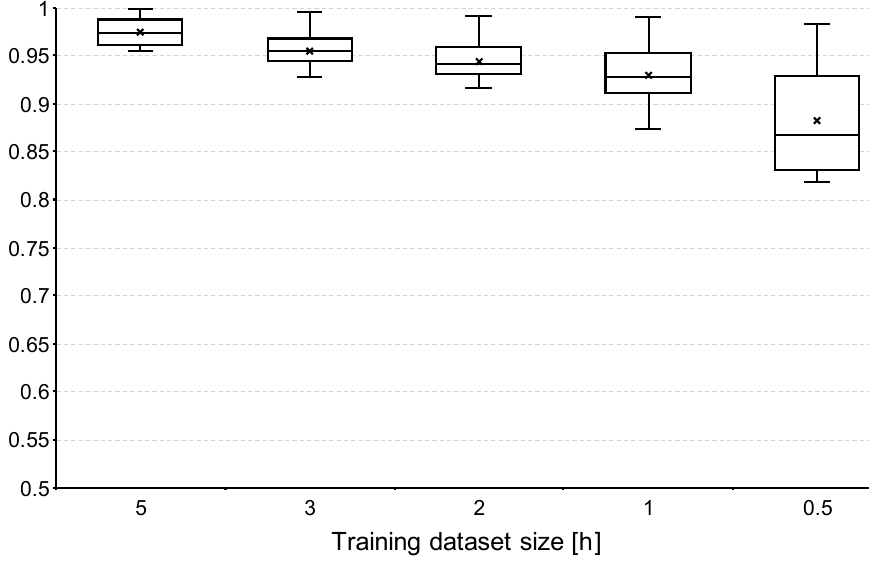
Figure 12. Experiment-3 results—training size.